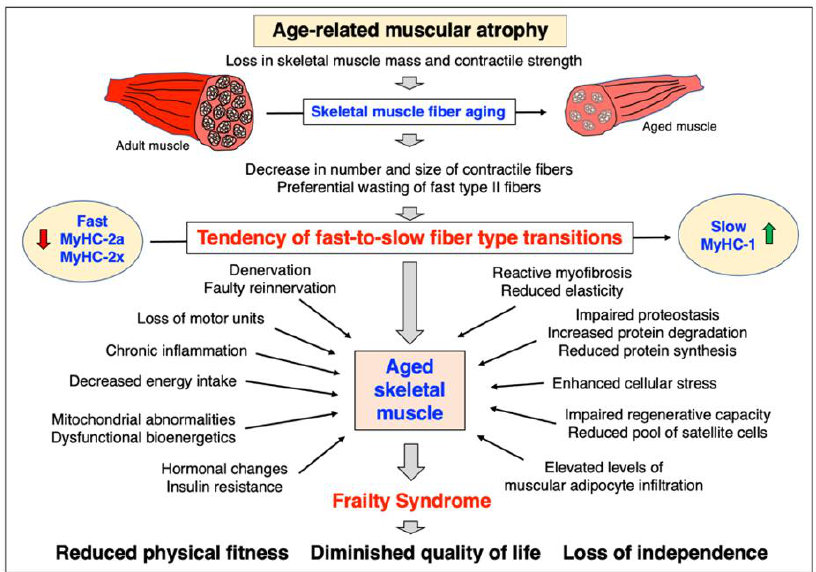
Figure 4. Overview of the multi-factorial changes during human skeletal muscle aging. The higher susceptibility of fast-twitching type II fibers causes a tendency of fast-to-slow transitions in senescent muscles. This is reflected by a switch from fast myosin heavy chain isoforms (MyHC-2a, MyHC-2x) to slower counterparts (MyHC-1) during skeletal muscle aging.